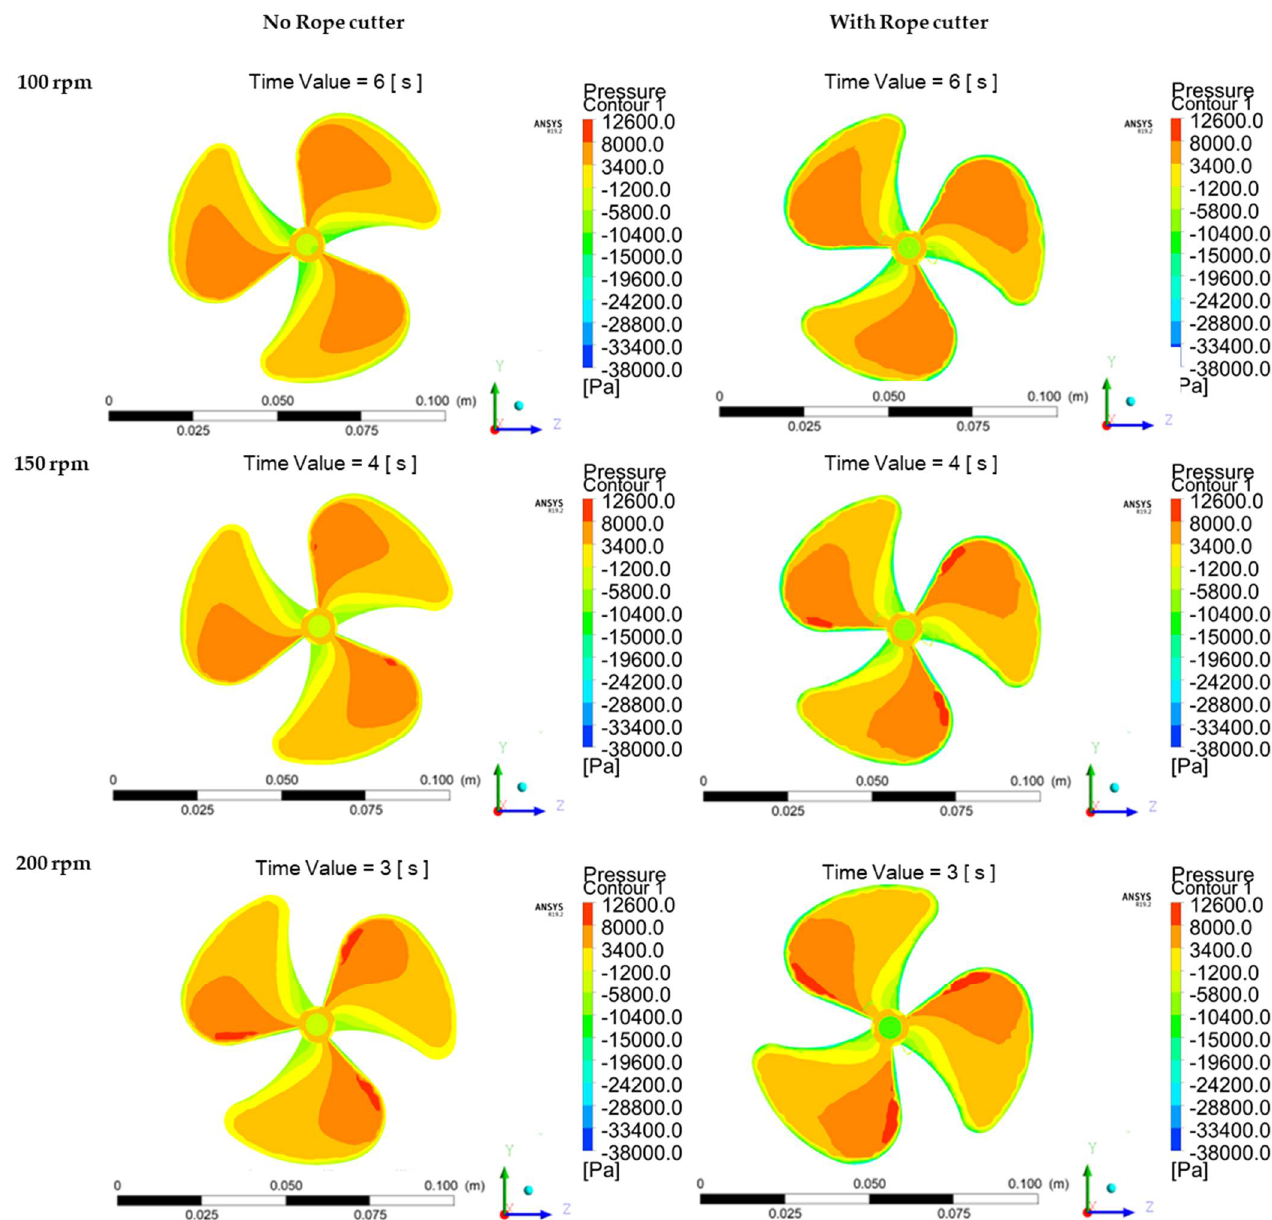
Figure 17. Pressure distribution on the propeller’s pressure (front) side [Pa].